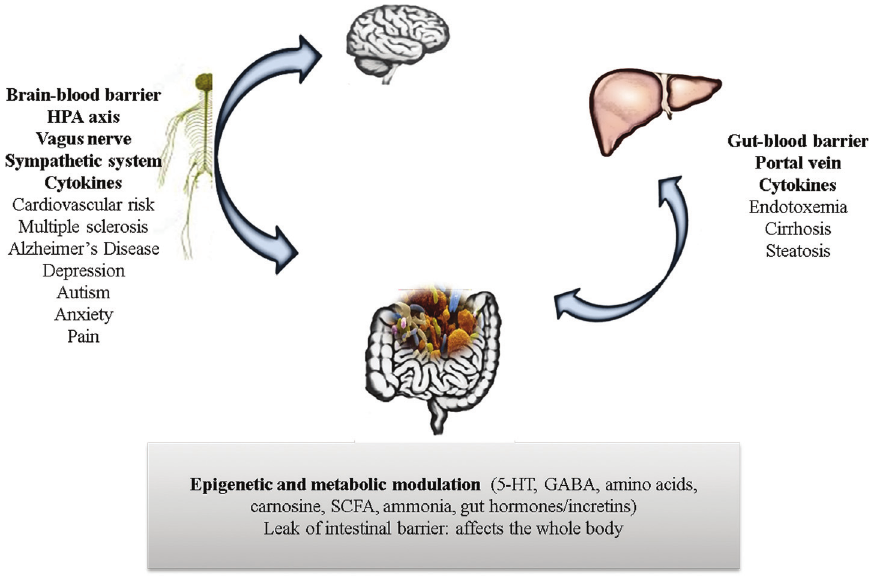
Figure 1 - Known effects of the gut microbiome on the main organs affected in an IEM. In bold are the ways by which the interactions occur. Below are the features related to the gut microbiota and the organs. The gut microbiome produces several metabolites and actively participates in the biosynthesis of vitaminsandcofactors,metabolismofcarbohydrates,proteinsandlipids.Thegutmicrobiotainteractswiththewholebodyviatheimmuneandendocrine systems. The two major organs affected in an IEM are the brain and the liver. In addition to the components of the immune and endocrine systems, the de- scribedgut-braininteractionsalsoinvolvethebrain-bloodbarrier,HPAaxis,vagusnerveandthesympatheticsystem.Thismaypredisposetoseveraldis- eases, such as increased cardiovascular risk, multiple sclerosis, Alzheimer’s disease, depression, autism, anxiety, and also can be related to pain. Interac- tions with the liver can occur via the portal vein, the gut-blood barrier, and can be involved in several hepatic diseases, most of them linked to